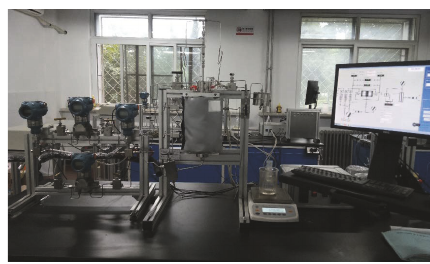
Figure 1: Coreflood setup in the lab.